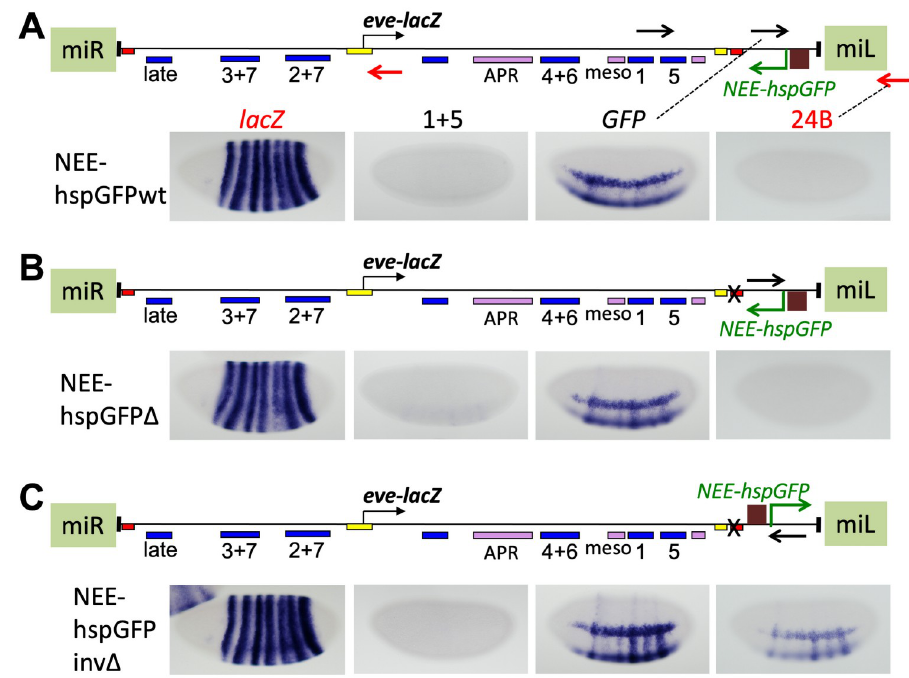
lettering corresponding to red arrows (detecting transcription from left to